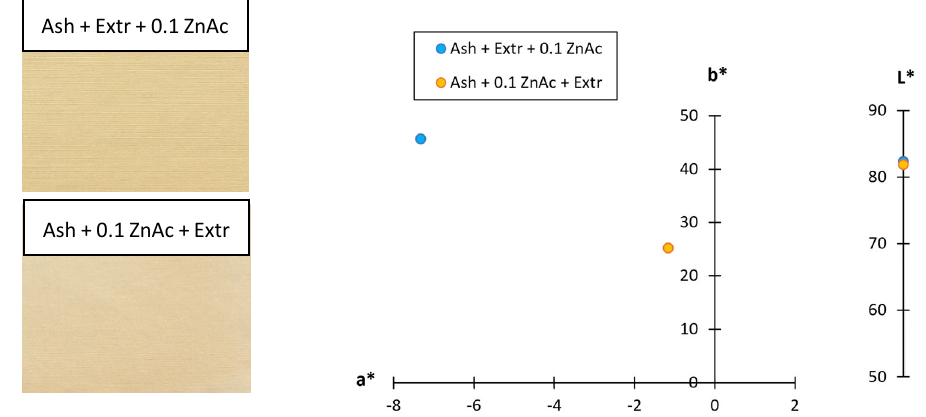
Figure 6. Scanned functionalised cotton samples and their CIE L*a*b* colour coordinates.